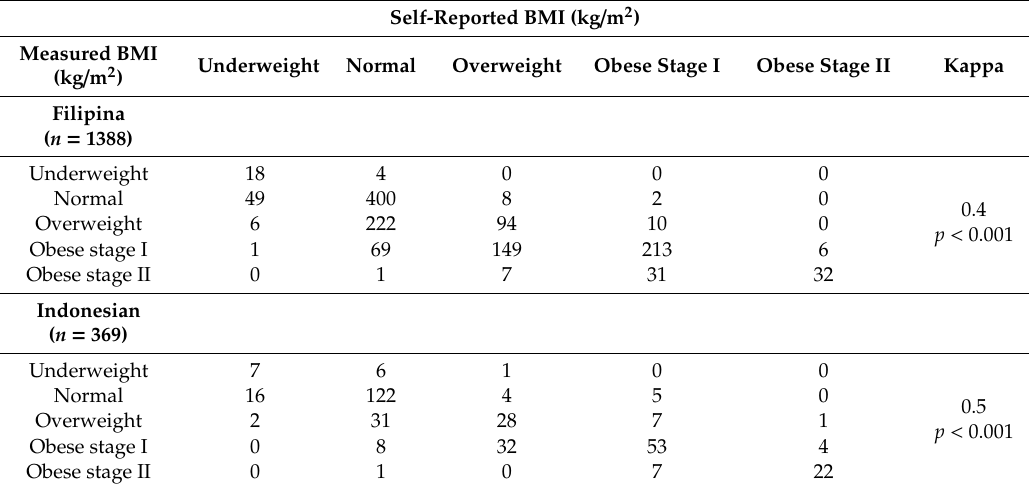
Table 2. BMI categories according to self-reported and measured BMI.